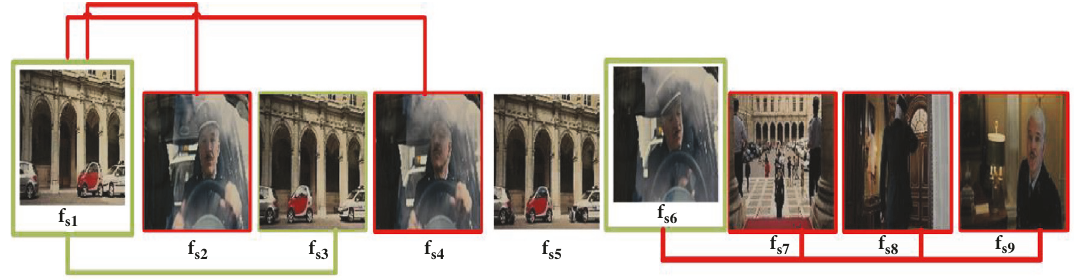
Figure 3: Example of key frames matchingin the sliding window of length L = 3 . Each frame representsthe shot, and thereare 9 consecutive ,. .. ,𝑓 } . Each key frame, 𝑓 shots {𝑓 𝑠 𝑠 9 𝑠 𝑖 , is matched with next three neighbors. 1